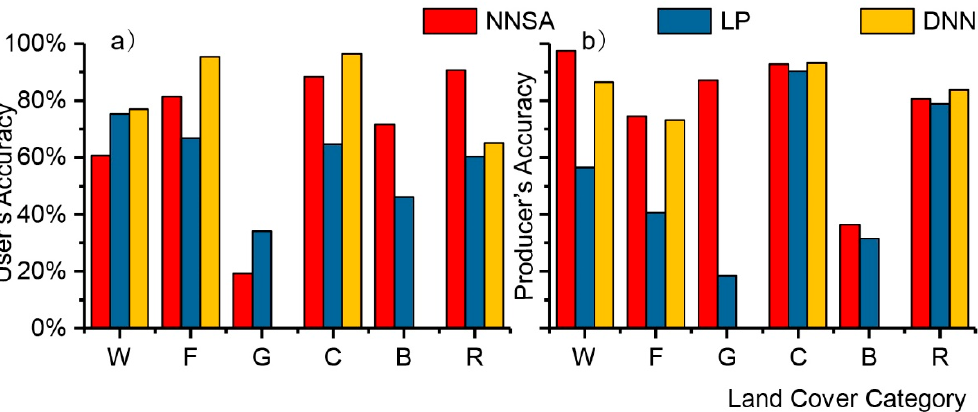
Figure 5. The accuracy assessment of sample augment results from NNSA in validation area with original samples including ( a ) user’s accuracy and ( b ) producer’s accuracy. The letters near the x -axis represent land cover categories. The land cover categories water, forestland, grass land, crop land, bare land, and residential and built-up land are denoted as W, F, G, C, B, and R, respectively.